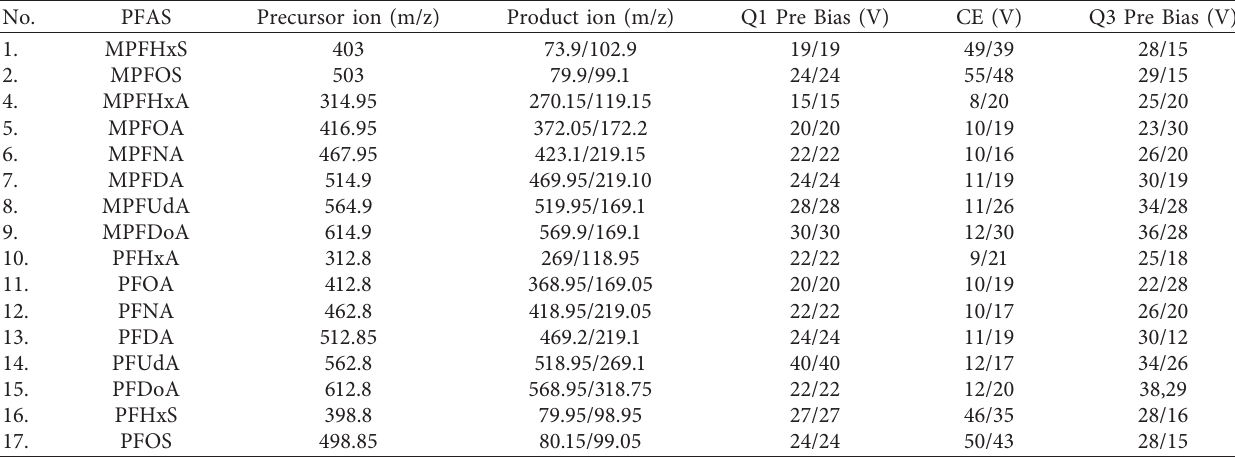
Table 1: MS/MS parameter for PFAS analysis.